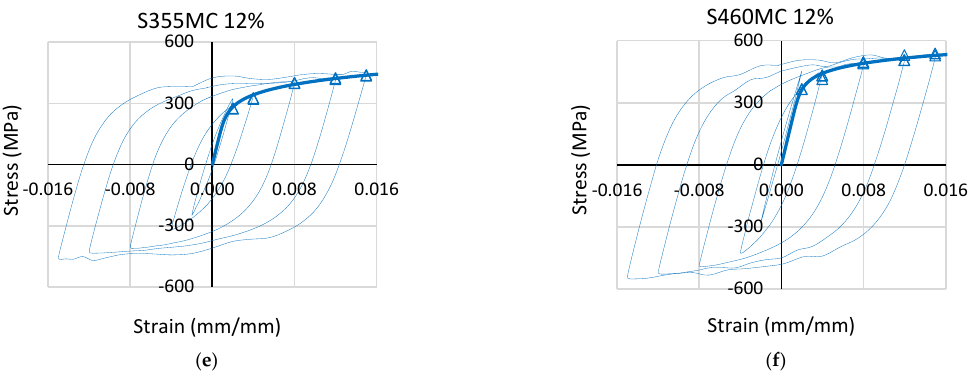
Figure 4. Stabilized stress – strain hysteresis loops of ( a , c , e ) S355MC and ( b , d , f ) S460MC steel for different pre-strain conditions.